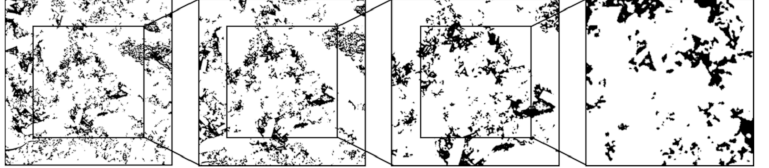
Figure 2. Varying size structures obtained from cropping operation. The resolution ratio is R = 1.0 and sample size changes from N = 1000 to N = 250 with a step of 250. Pores are shown in black and solid in white. Only a 2D slice is presented in the figure.